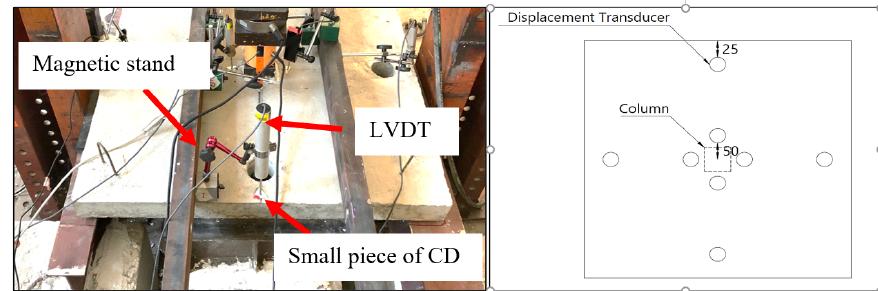
Figure 7. Location & placement of LVDTs.